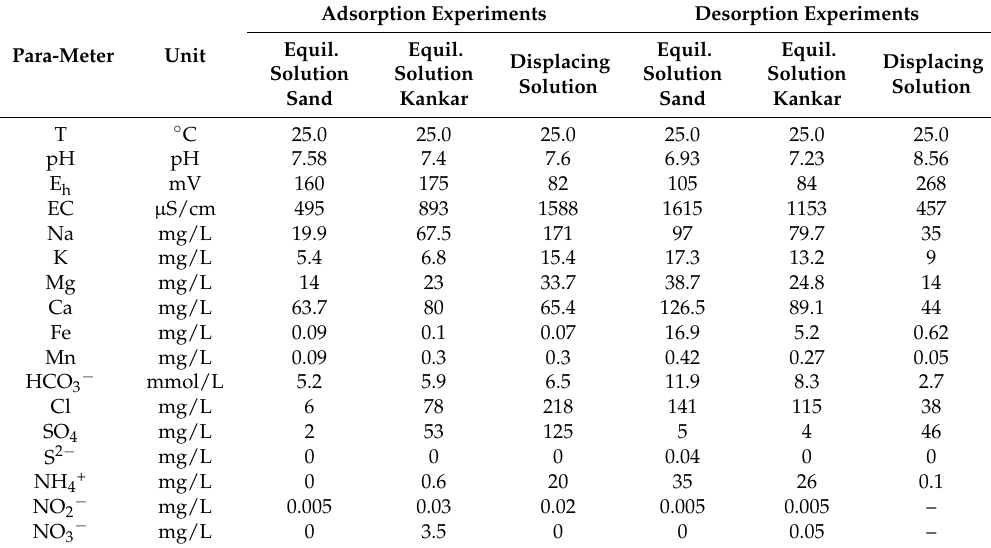
Table 4. Adsorption and desorption modeling: Composition of the equilibrating and displacing solutions. Adsorption Experiments Desorption Para-Meter Unit